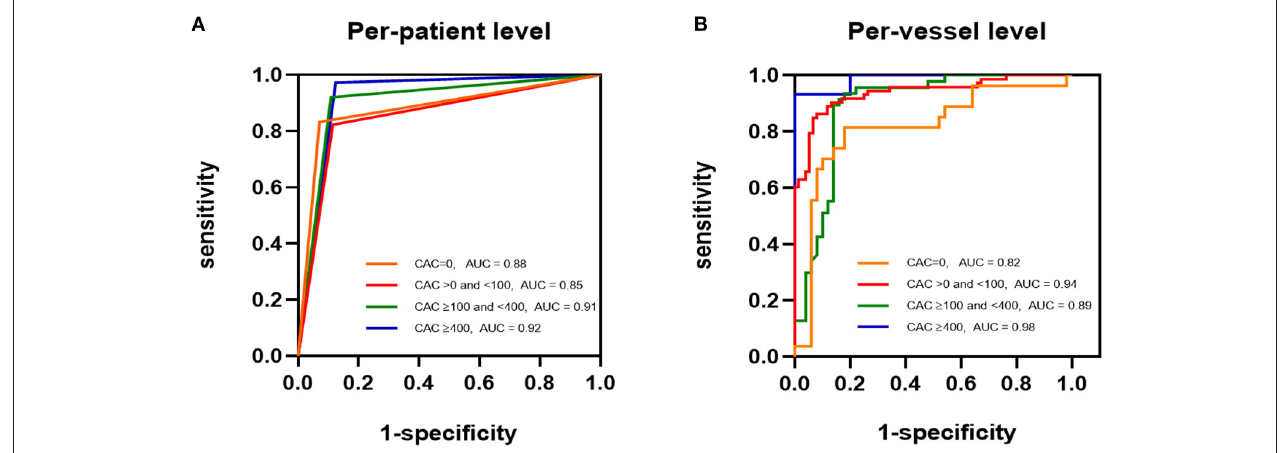
FIGURE 4 | ROCs of CT-FFR Identifying Flow-limiting Lesions. ROCs for detection of ischemia with CT-FFR among all CAC score groups [ (A) , per-patient level; (B) , per-vessel level]. CAC, coronary artery calcium; CT-FFR, computed tomography derived fractional flow reserve.